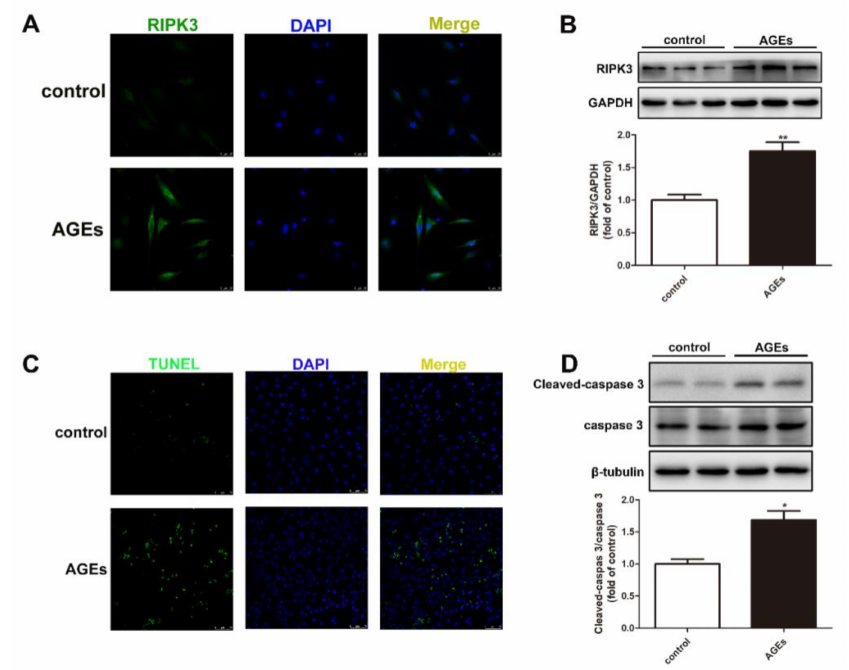
Figure 2. AGEs induced necroptosis in cardiomyocytes. Cardiomyocytes were stimulated with AGEs (200 µ g/mL) for 24 h. ( A ) RIPK3 was immunofluorescence stained by Alexa Fluor 488 (Green)- conjugated IgG. The nuclei were stained by DAPI (Blue). Bar = 25 µ m. ( B ) The expression of RIPK3 was detected by Western blot in cardiomyocytes. GAPDH was used as a loading control. ( C ) The apoptosis of cardiomyocytes was detected by One Step TUNEL Apoptosis Assay Kit. Bar = 75 µ m. ( D ) The expression of caspase 3 and Cleaved-caspase 3 was detected by Western blot in cardiomy- ocytes. β -tubulin was used as a loading control. Plots represent the mean ± SEM; n = 6. Statistical significance: * p < 0.05, ** p < 0.01 compared with